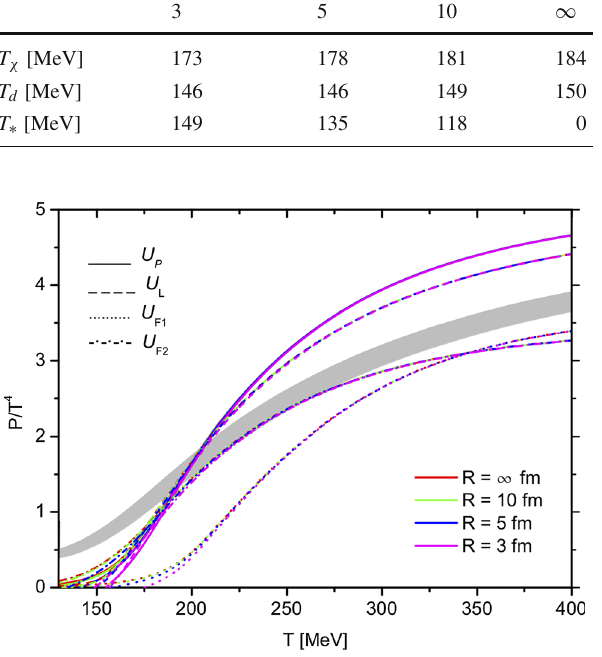
Table 3 Same as in Table 1 but for the Polyakov loop potential of Fukushima, version U F 1